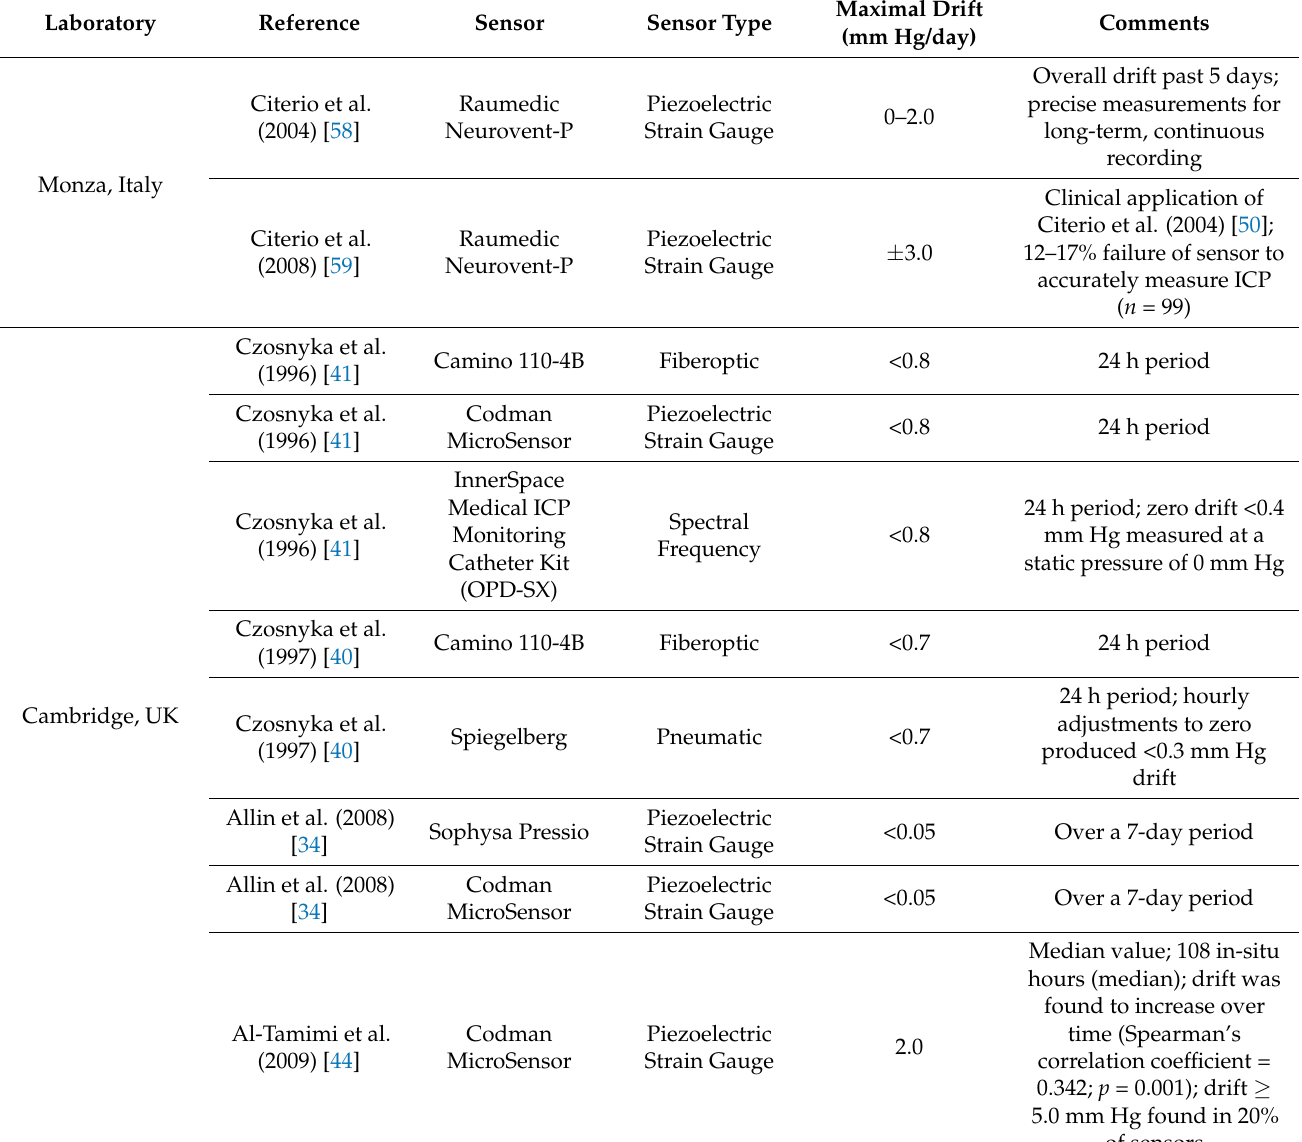
Table A1. Comparison of Zero Drift Among Different ICP Sensors. mm Hg—millimeters of